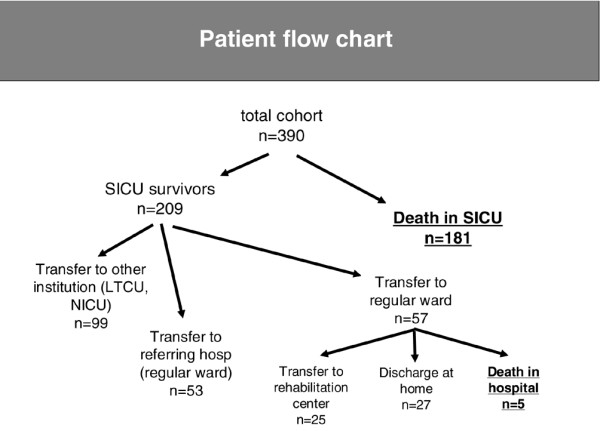
Patient flow after inclusion in the study. LTCU, long-term care unit; NICU, neurological intensive care unit; SICU, surgical intensive care unit.